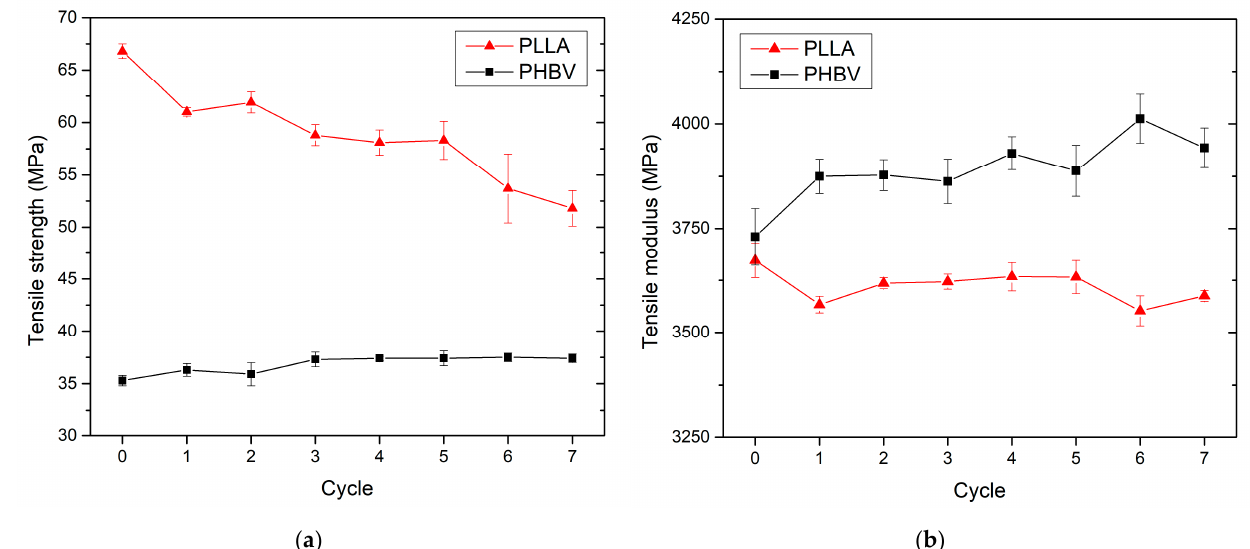
Figure 9. PLLA and PHBV tensile properties as a function of recycled cycle: ( a ) tensile strength; ( b ) tensile modulus.